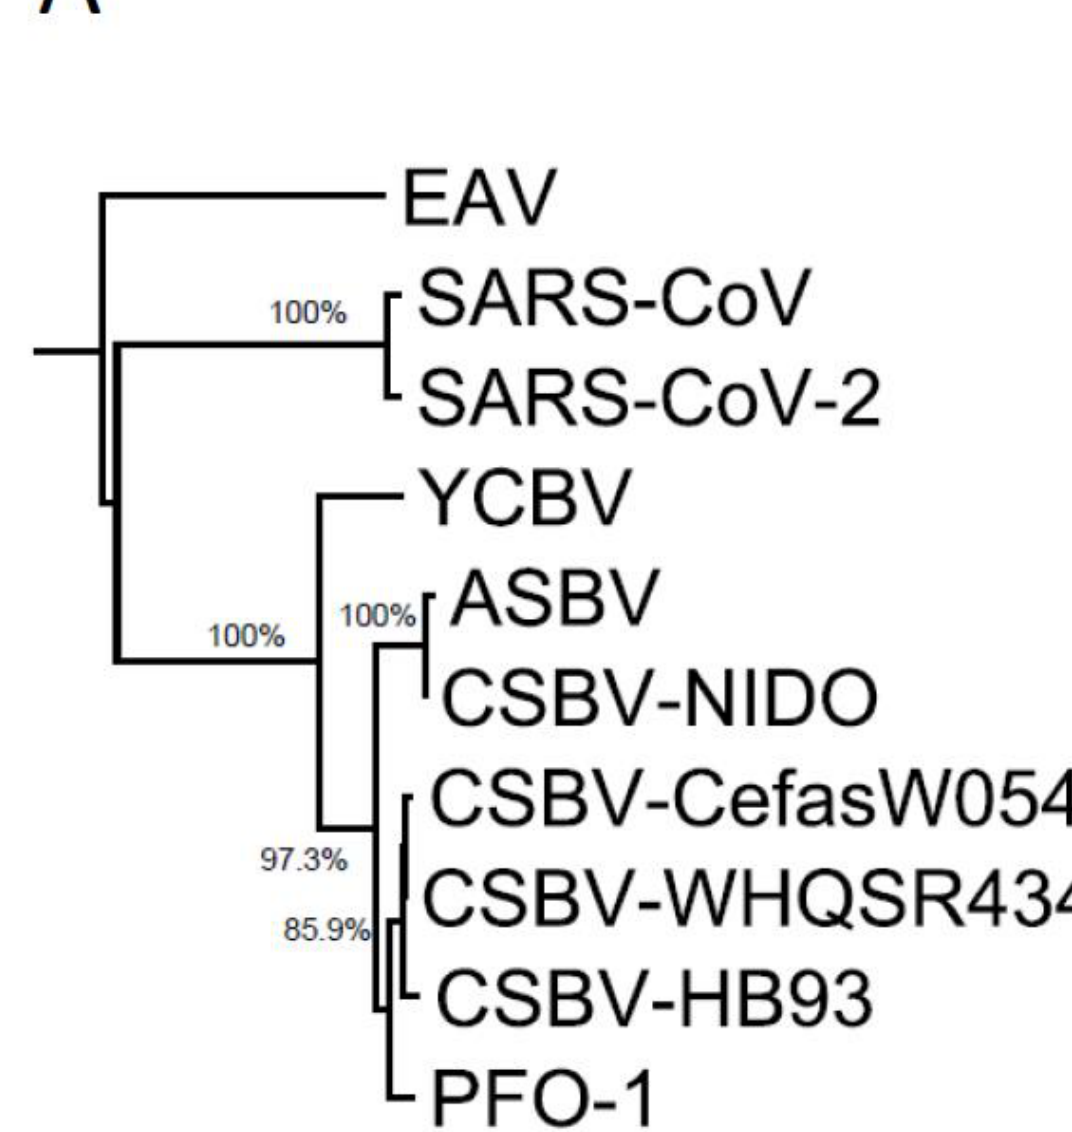
Figure 3. Phylogeny of selected nidoviruses based on the amino acid and nucleotide sequences of the E proteins. Phylo- genetic tree based on ( A ) amino acid sequences and ( B ) nucleotide sequences, of seven members of genus Oncotshavirus (listed in Table 1) and two members of genus Betacoronavirus , lineage B (SARS-CoV and SARS-CoV-2) with Equine arteritis virus (EAV) E protein sequence GenBank accession number: NC_002532) as the outgroup to determine its root. The graphical editor for phylogenetic trees, TreeGraph 2 [57] was used to produce the figures. Each bootstrapping value corresponds to the branch on the same vertical level. Only the bootstrapping supports higher than 70% are marked in the phylogenetic trees. Abbreviations at the end of each sequence correspond to the virus names: ASBV = Atlantic salmon bafinivirus VT01292015-09; CSBV-NIDO = Chinook salmon bafinivirus NIDO; CSBV Cefas-W054; CSBV WHQSR4345; CSBV HB93; YCBV = Yellow catfish bafinivirus Shaoxing; PFO-1 = Pelteobagrus fulvidraco oncotshavirus-1 ZJLH18531; SARS-CoV = Severe acute respiratory syndrome coronavirus Tor2; SARS-CoV-2 Wuhan-Hu-1; and EAV = Equine arteritis virus